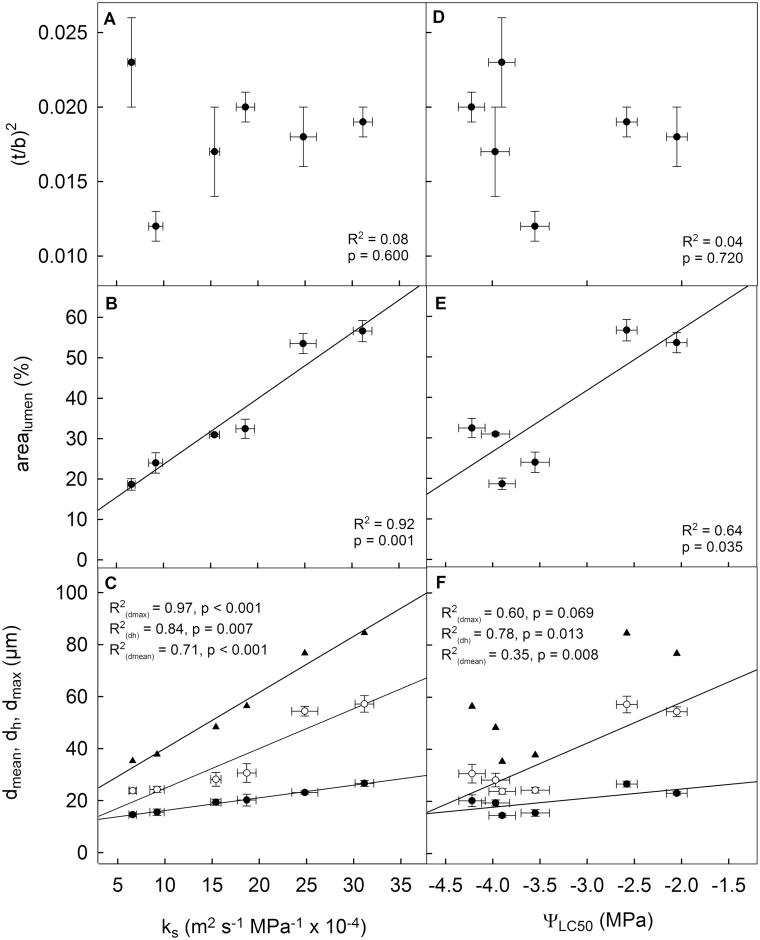
Correlation of wood anatomical parameters with specific hydraulic conductivity (ks) and vulnerability to cavitation (water potential at 50% loss of conductivity; ΨLC50). (A, D) Cell wall reinforcement [(t/b)2], (B, E) percentage of xylem area covered by conduit lumen (arealumen), and (C, F) mean conduit diameter (dmean; filled circles), mean hydraulic diameter (dh; open circles), and maximum diameter (dmax; triangles). Data presented are means ±SE of juvenile branches, adult branches, and the main stem from different sampling heights.